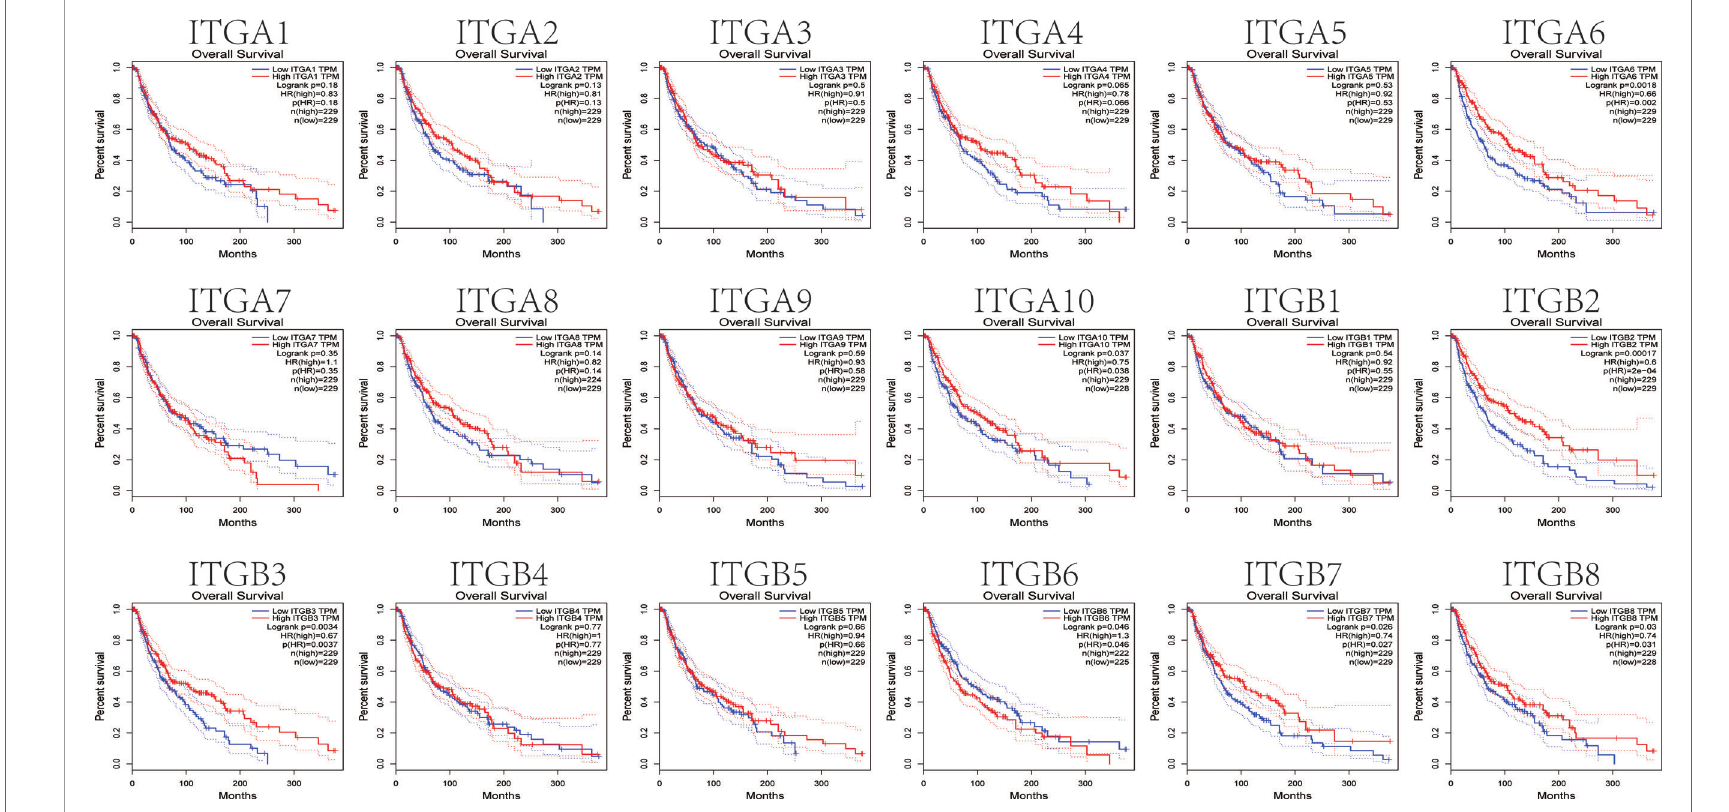
FIGURE 6 | The prognostic value of differentially-expressed integrin subunits in the overall survival curve (GEPIA) for SKCM patients. Prognostic analysis was performed using a Kaplan – Meier curve. The p value was set at